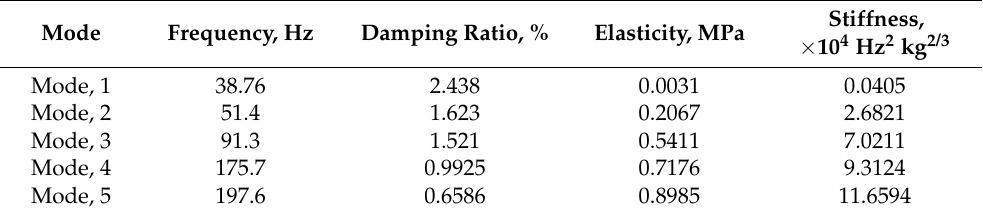
Table 5. Determining the natural frequency, damping ratio, elasticity, and stiffness factor for can- taloupe fruit for the pattern packing method.